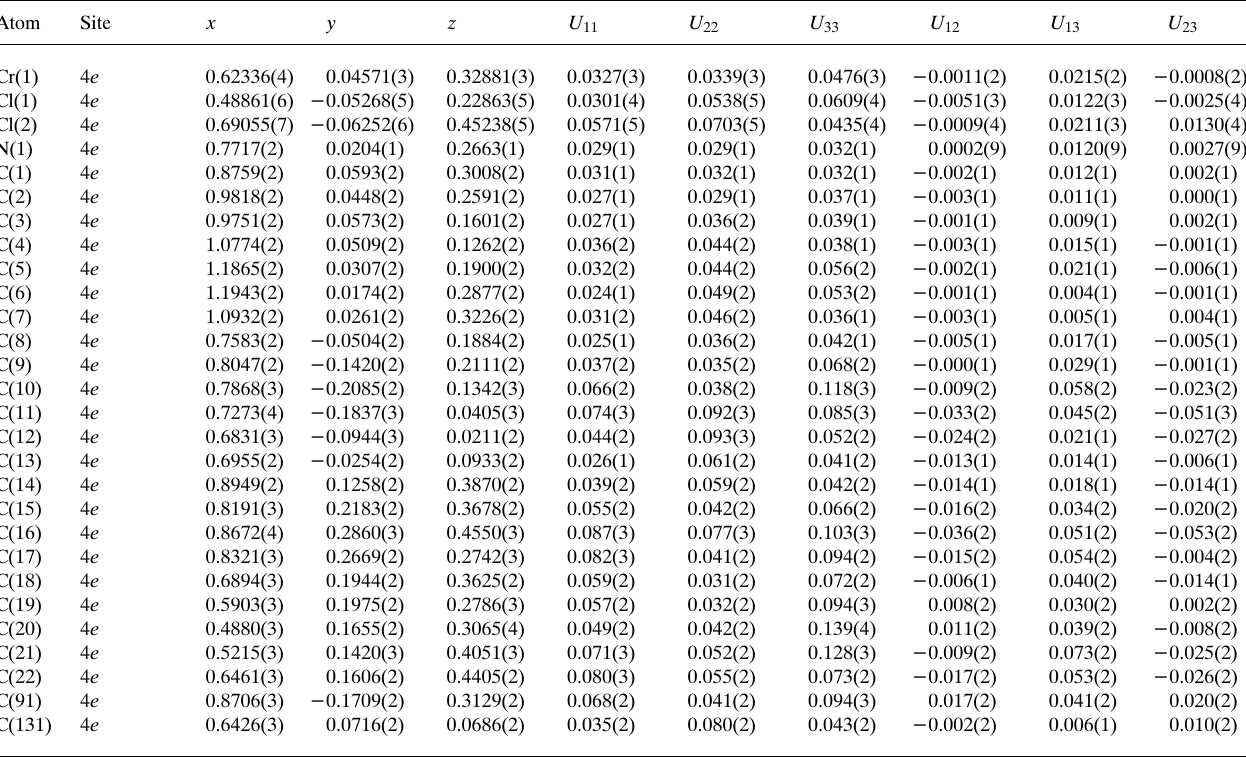
Table 3. Atomic coordinates and displacement parameters (in Å 2 )